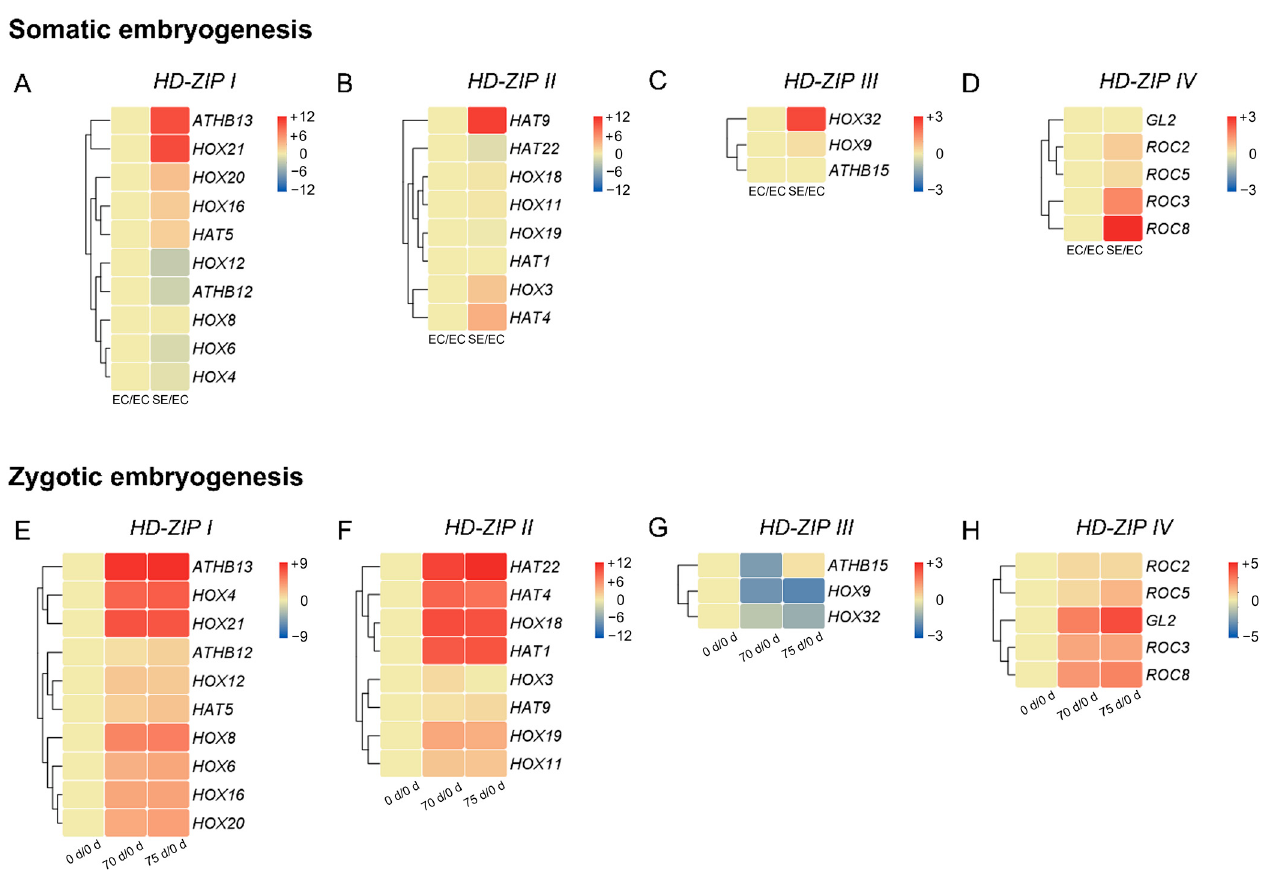
Figure 5. In silico expression analysis of EgHD-ZIP genes during oil palm zygotic and somatic em- bryogenesis. Heat map represents Log 2 FC of FPKM somatic embryo (SE)/embryogenic callus (EC) for somatic embryogenesis and Log 2 FC of FPKM (70 d/0 d and 75 d/0 d) for zygotic embryogenesis of EgHD-ZIP I ( A , E ), II ( B , F ), III ( C , G ), and IV ( D , H ) genes. The 0 d, 70 d, and 75 d indicate the day of zygotic embryogenesis during seed germination. Red color indicates up-regulation and blue color indicates down-regulation.